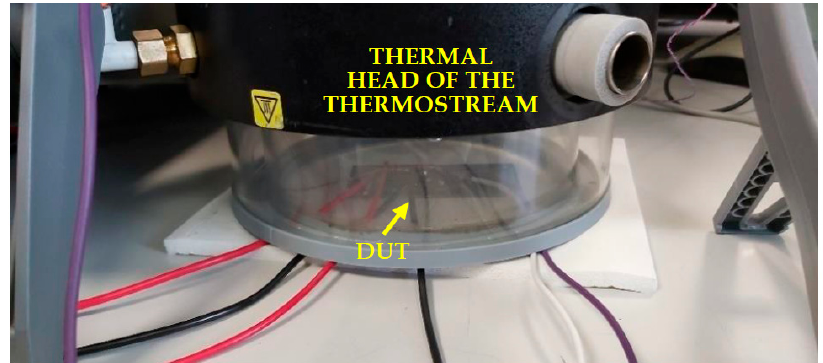
Figure 4. The device under the airflow.